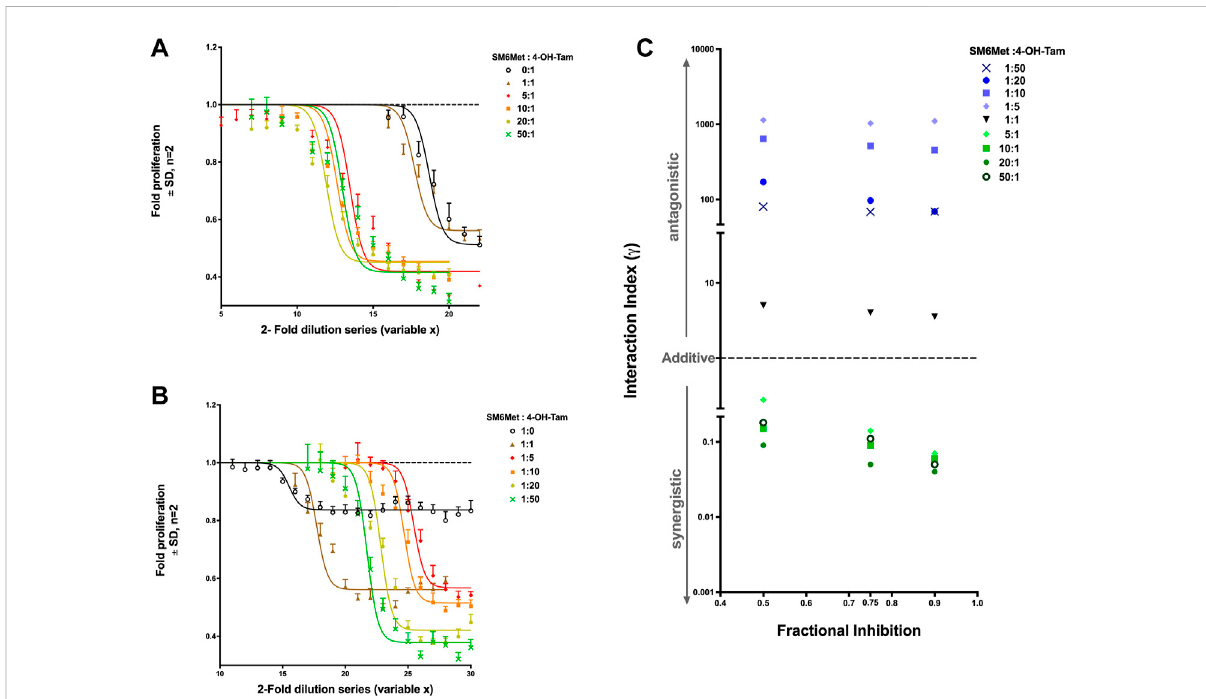
FIGURE 2 Synergistic effect of SM6Met and 4-OH-Tam in attenuating E 2 -induced breast cancer cell proliferation. MCF-7BUS cells were treated with combinations with a higher ratio towards SM6Met (A) and combinations with a higher ratio towards 4-OH-Tam (B) using a 2-fold dilution series of each combination ratio in the presence of 10 − 11 M E 2 for a period of 7 days wherein there were two retreatments. Thereafter, the number of viable cells were measured using the MTT assay and dose response curves were generated using non-linear regression curve- fi tting, speci fi cally the log(inhibitor)vs.response (threeparameters) equation inGraphPadPrism wasemployed withthetopof thecurveconstrained to 1,to determinethe potency and ef fi cacy values of each combination. Average ± SD is of two independent biological experiments done in quadruplicate. The results wereexpressedas fold proliferation relativeto thepositive control, 10 − 11 ME 2 , whichissetat1.See Supplementary Figure S2for results fromsolvents andE 2. (C) InteractionindexcalculatedandplottedforeachcombinationratioofSM6Met:4-OH-Tam atthe50%,75%and90%inhibitionlevelofE 2 - induced breastcancercellproliferation.Ifthecombinationissynergistic,theindexwillbelessthanone( γ < 1),ifadditiveitwillbeequal toone( γ =1), while if it is antagonistic the index will be greater than one ( γ >